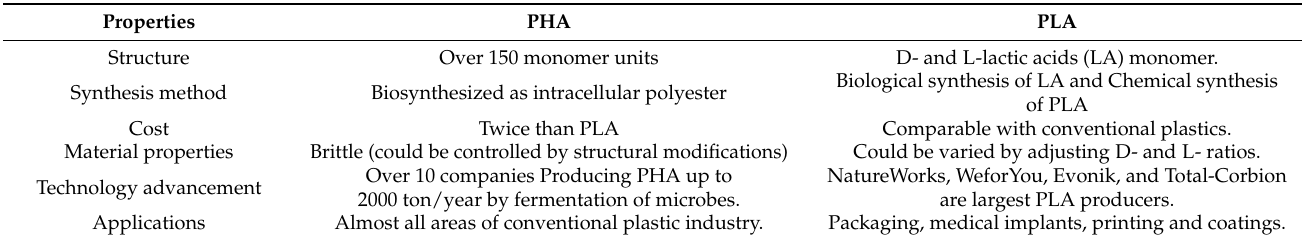
Table 1. Comparison of polyhydroxyalkanoates (PHA) and polylactic acid